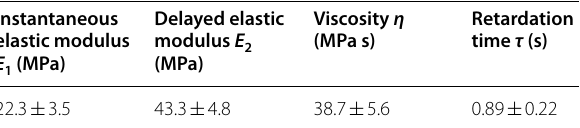
Table 2 Viscoelastic parameters measured by creep experiment (Mean SD, n 3) ± = Instantaneous elastic